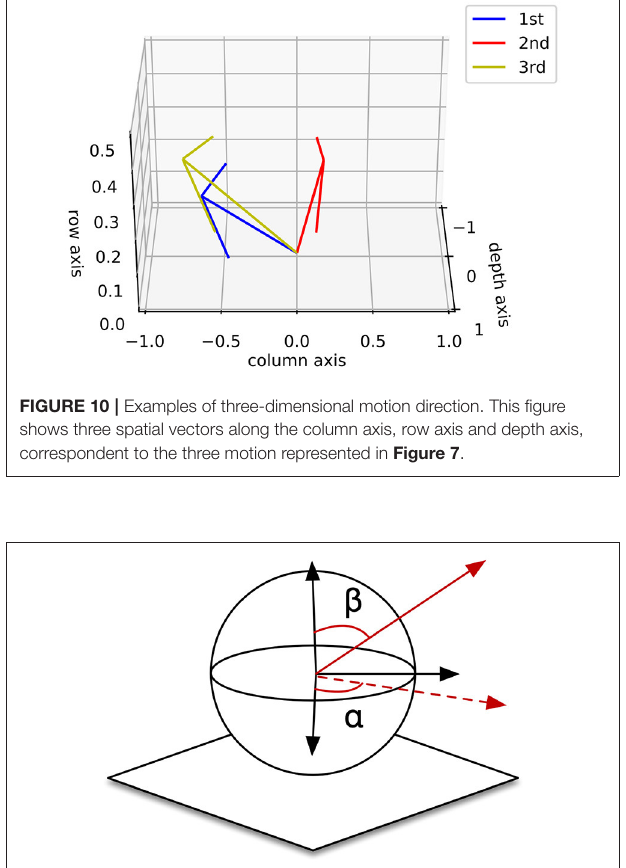
FIGURE 11 | Definition of spatial vectors.